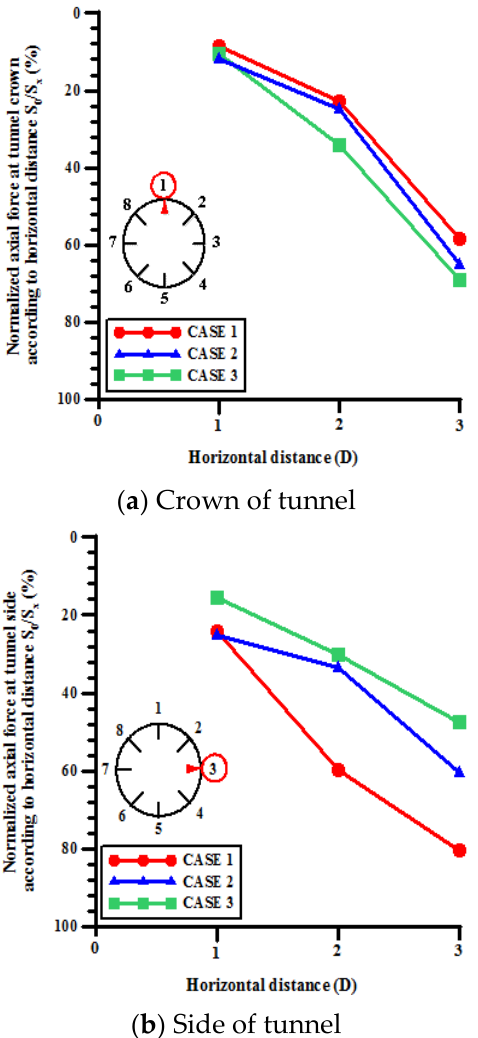
Figure 15. Normalized axial force by allowable load according to horizontal offset.